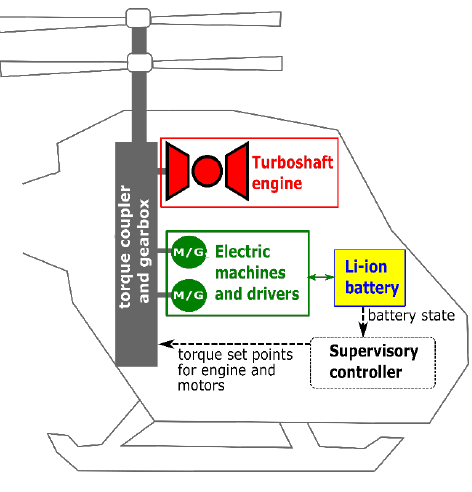
Figure 1. The hybrid electric power system.